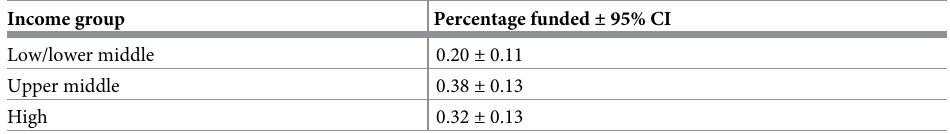
Table 4. Preprint reporting of funding. Percentage of medRxiv preprints from each income group that report external